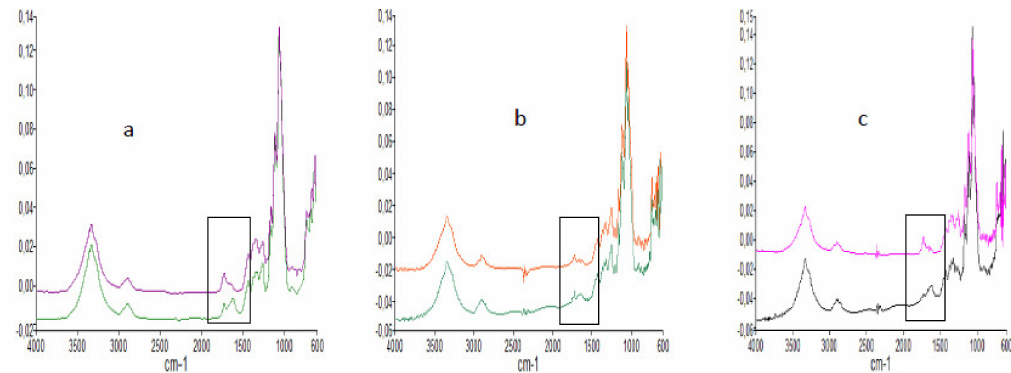
Figure 7. ( a ) PET-CNC COOR (green) and corona treated PET-CNC COOR (violet); ( b ) PET-CNC SO3H (green) and corona treated PET-CNC SO3H (red); and ( c ) PET-CNC COOH (black) and corona treated PET-CNC COOH (violet).